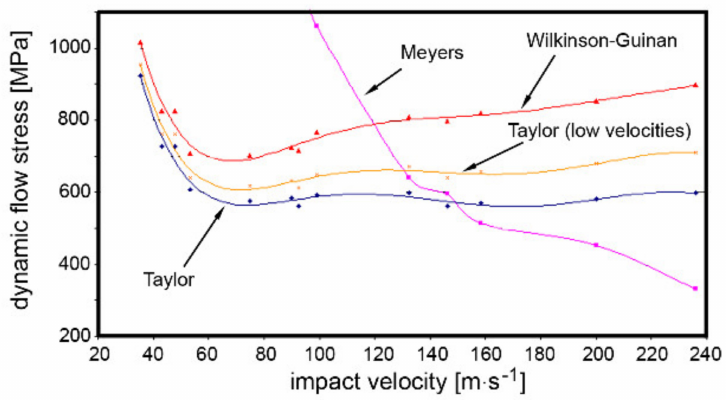
Figure 8. Dependences of dynamic flow stress on impact velocity for tested specimen calculated after selected